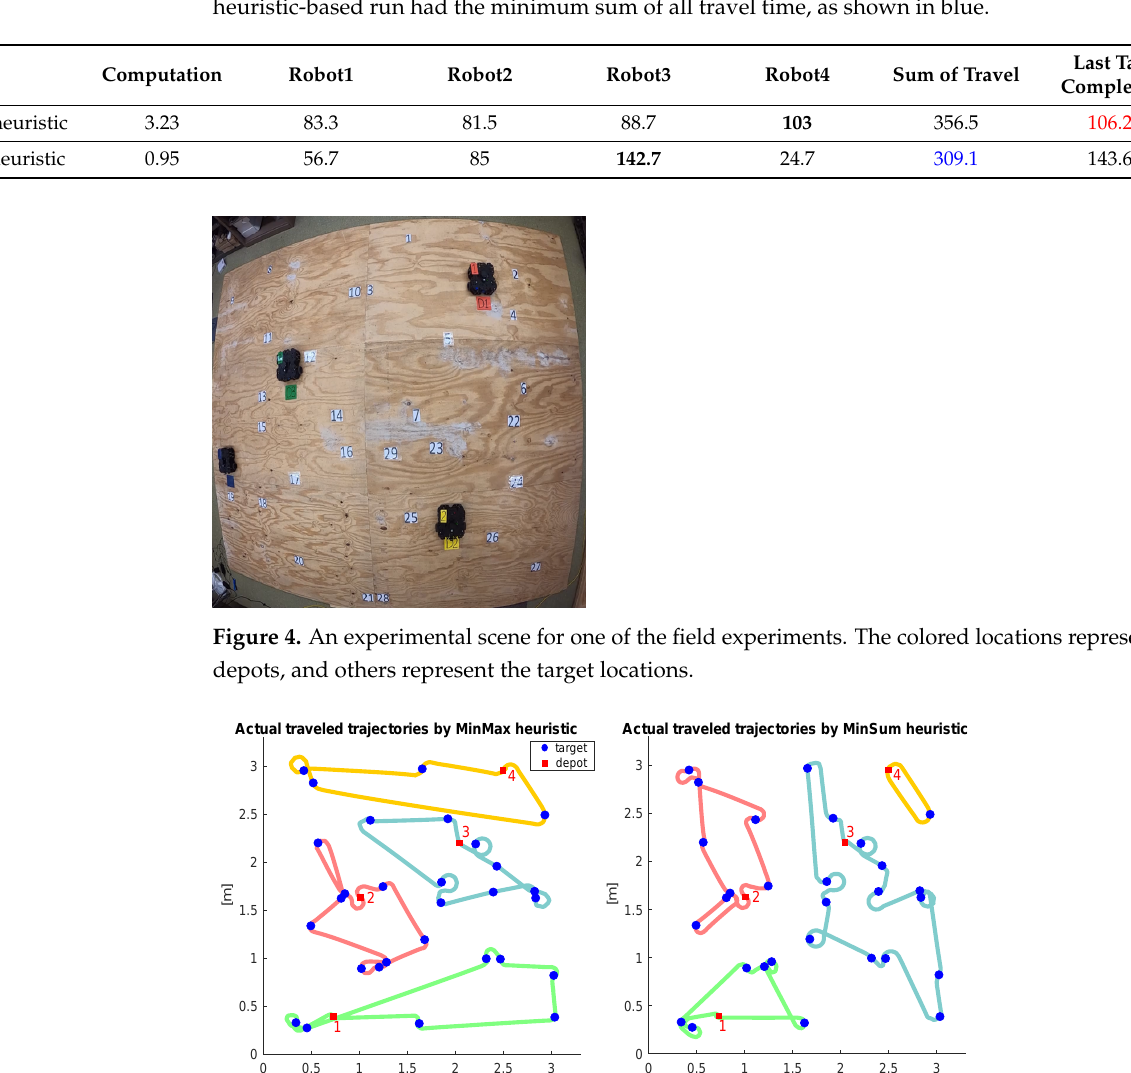
Table 2. Computation and travel time in seconds of the field experiments. The min-max heuristic- based run had the minimum last task completion time, as presented in red, and the min-sum heuristic-based run had the minimum sum of all travel time, as shown in blue.